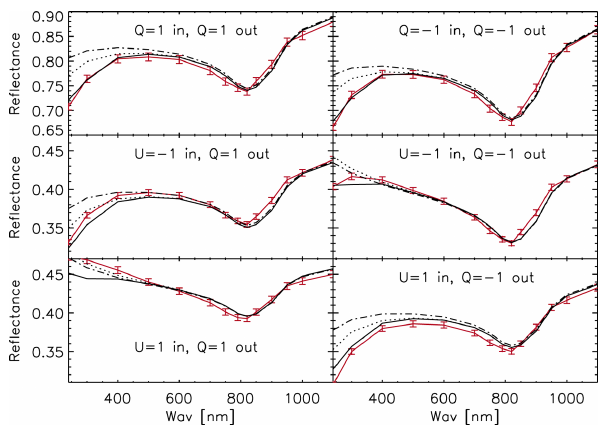
Figure 7. SCIAMACHY scan mirror reflectance for different po- larisation states of the incident light ( Q = 1, Q = − 1, U = 1, and U = − 1 with respect to the SCIAMACHY reference frame) and different orientation of the analysers ( Q = 1 and Q = − 1), as in- dicated in the subplots. The measurement results with error bars obtained during on-ground calibration are shown in red, while the model calculations are represented by the black solid curve. The model calculation includes an aluminium mirror with 4.1nm alu- minium oxide and 0.4nm light oil contamination, and angles of in- cidence φ ESM = 12 . 7 ◦ and φ ASM = 45 ◦ . Dash–dotted curves in- dicate clean aluminium, and dotted curves aluminium with only 4.1nm aluminium oxide, as a comparison.